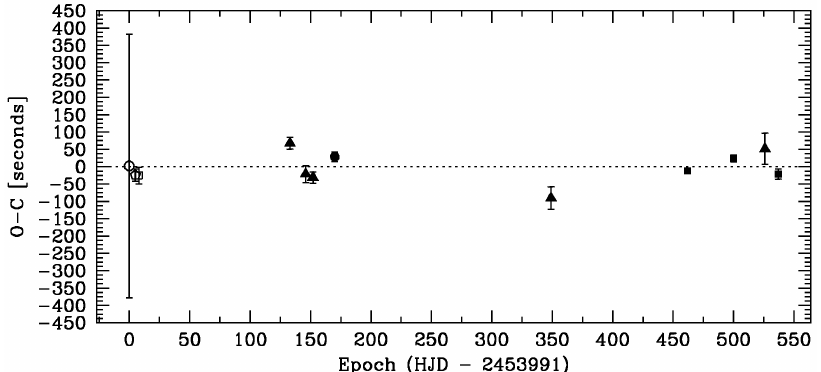
Figure 2.: Timing measurements for WASP-2b: solid triangles - this work, open circles - Collier-Cameron et al. (2007), stars - Wheatley et al. (2010), squares - Charbonneau et al. (2007), solid circles - Hrudkova et al. (2009), solid squares - Southworth et al. (2010). The ephemeris are from Southworth et al.